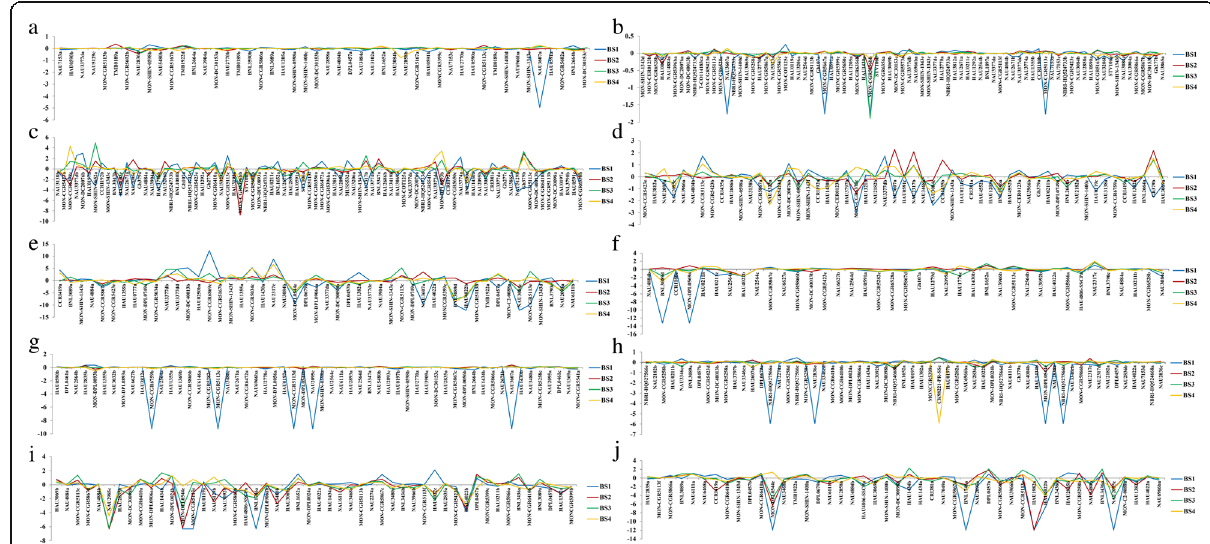
Fig. 5 The change trends of phenotypic effect of marker loci associated with ten yield-related traits in the four breeding stages. a SCW (seed cotton weight), b LW (lint weight), c LP (lint percentage), d EBN (effective boll number), e PH (plant height), f FFSH (first fruit spur height), g FSBN (fruit spur branch number), h FFBP (first fruit branch position), i FP (flowering period), j WGP (whole growth period). The four different colored lines indicate four different breeding stages